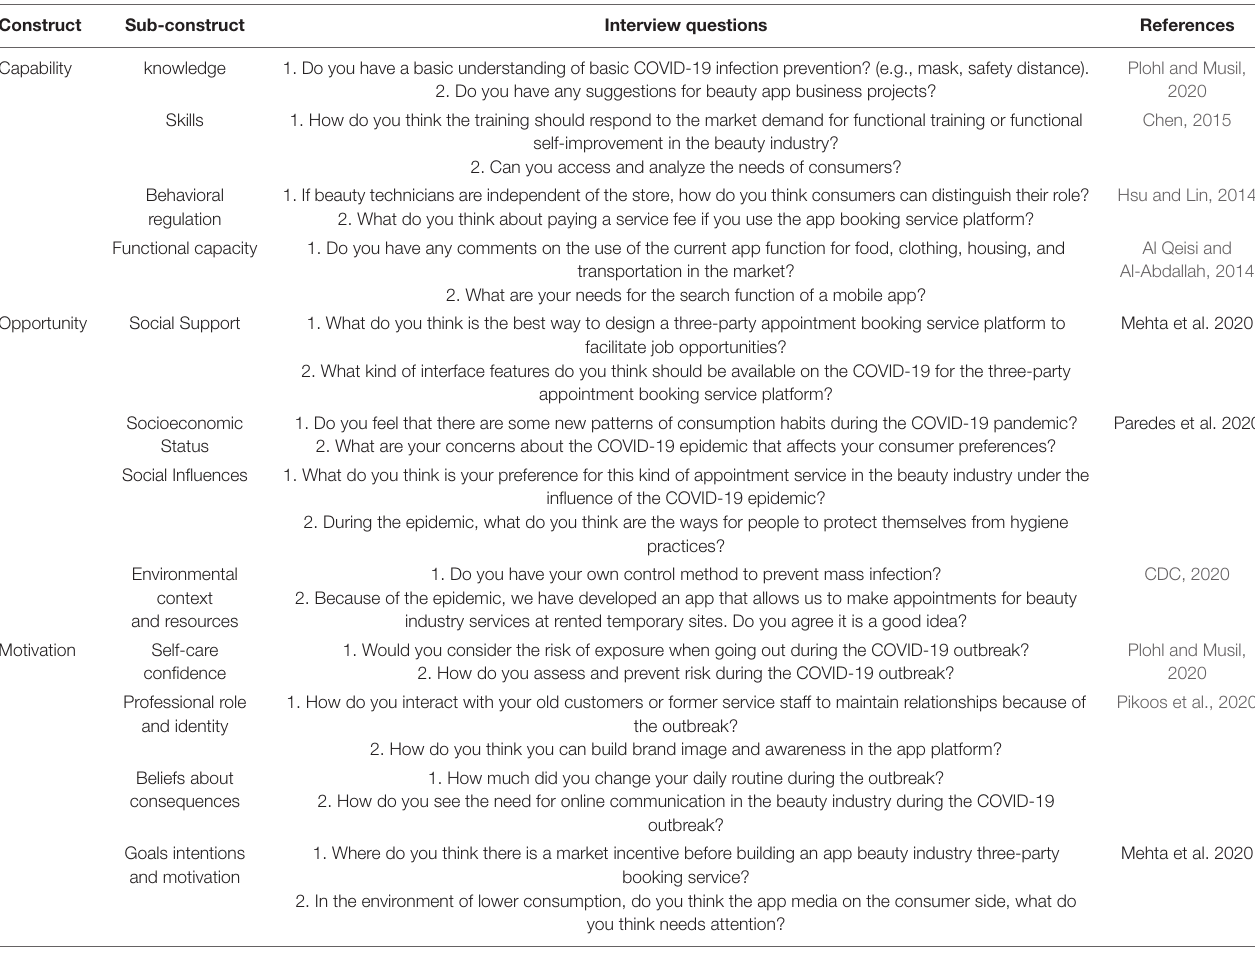
TABLE 1 | Focused interview group questions based on the COM-B